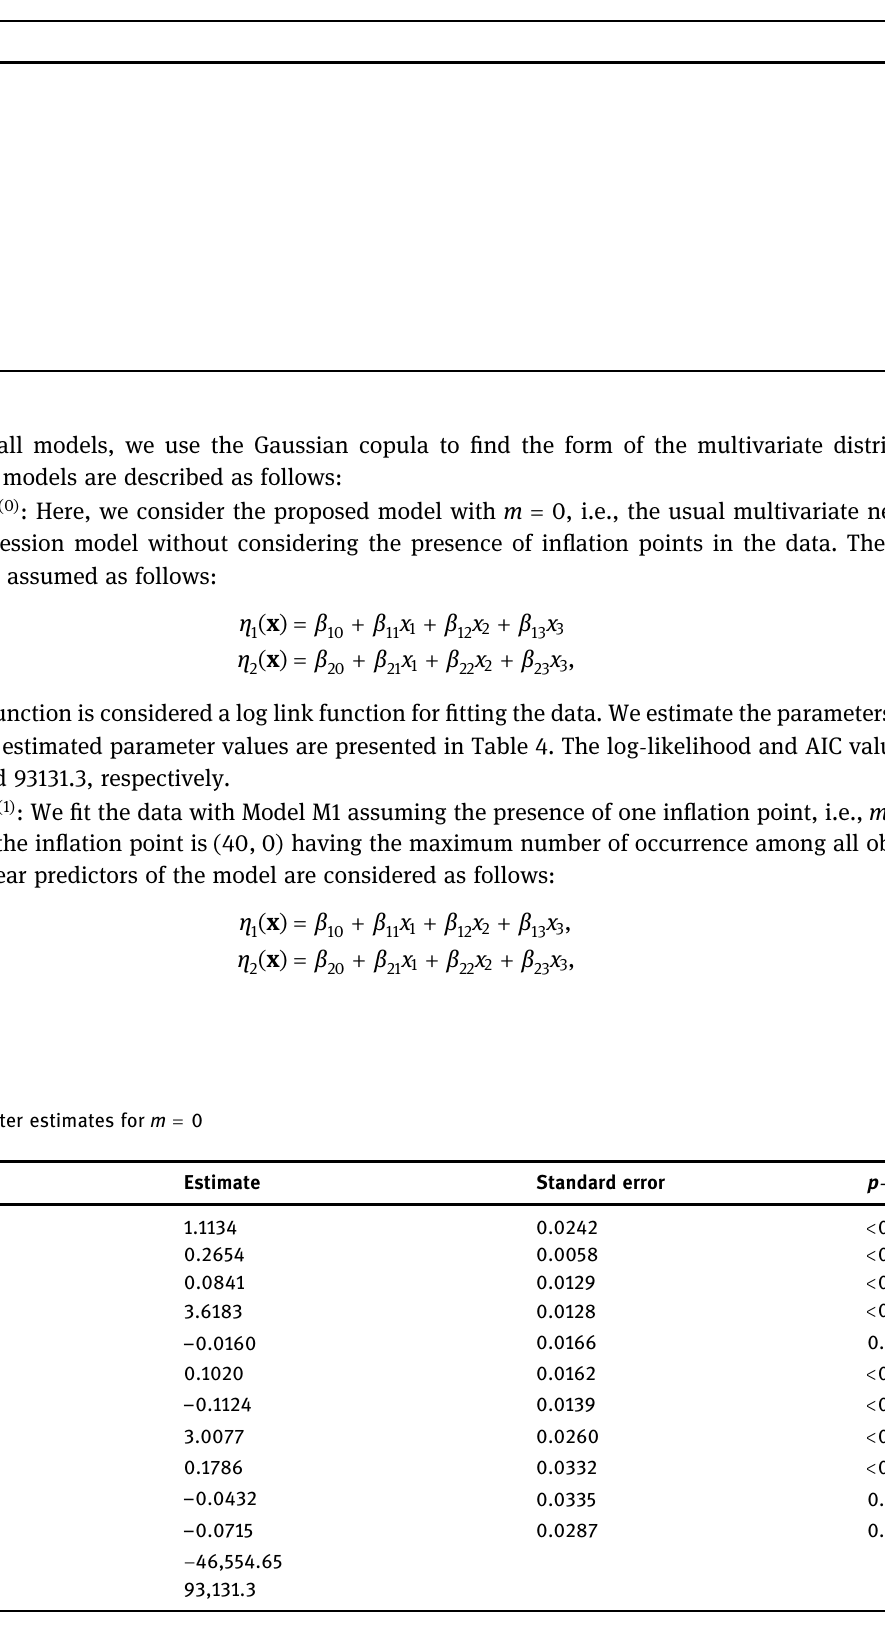
Table 3: Ten points with highest counts Point